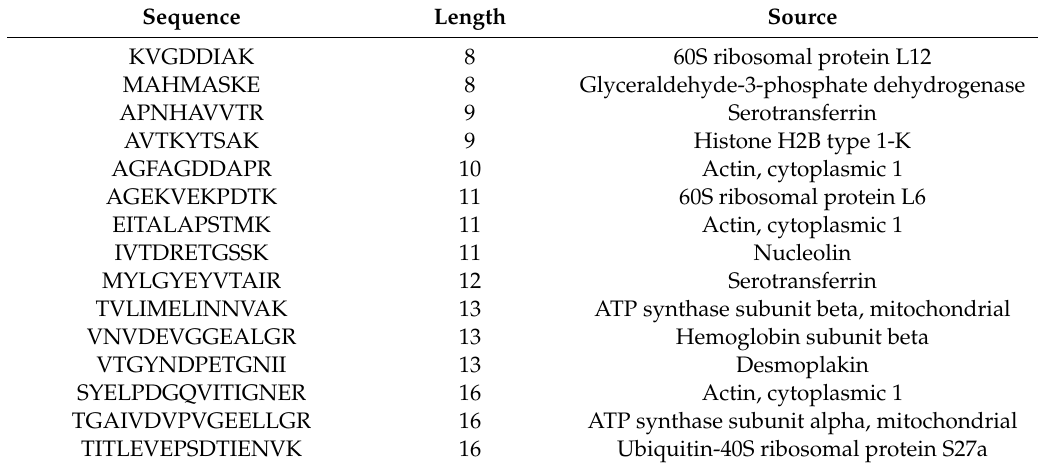
Table 2. Shared peptides between HLA-F*01:01, F*01:03 and F*01:04.